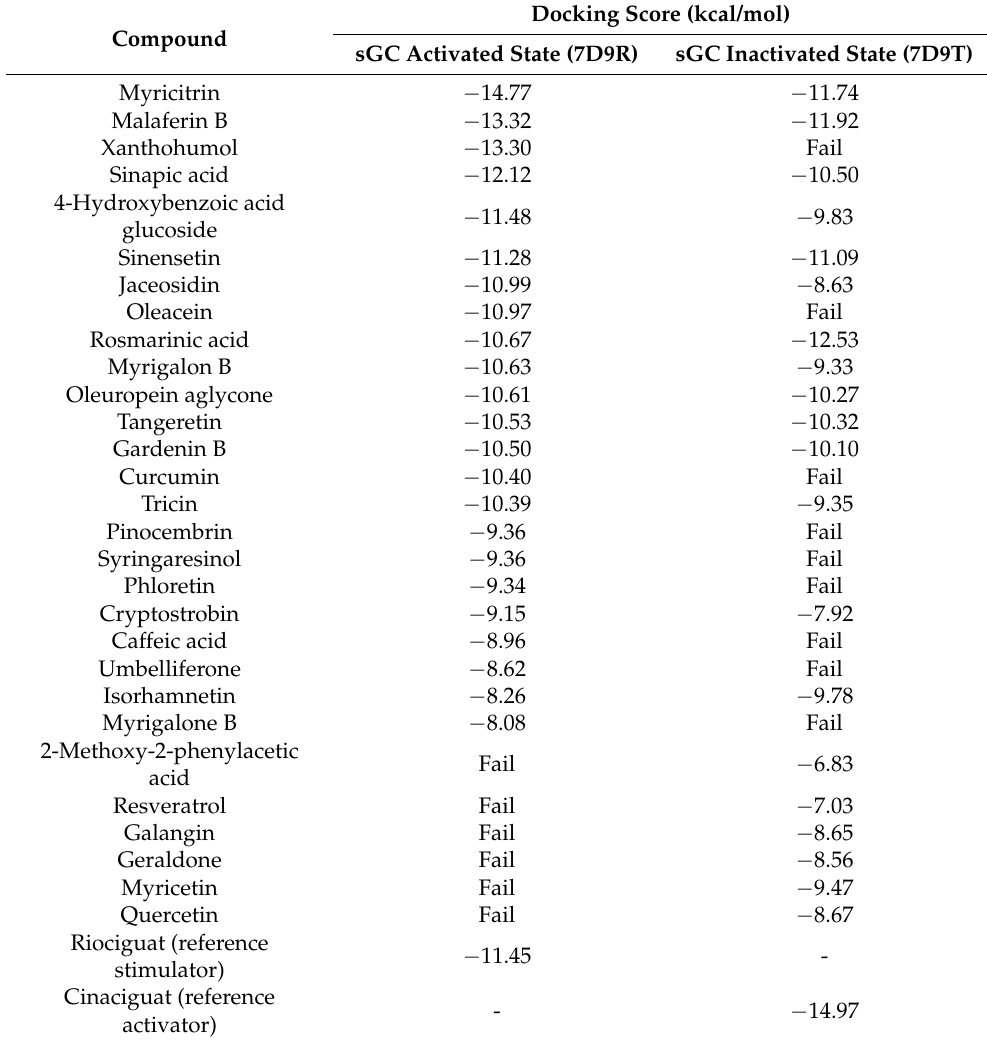
Table 1. Docking scores obtained upon docking the major constituents in S. samarangense extract into sGC receptors in the activated and inactivated